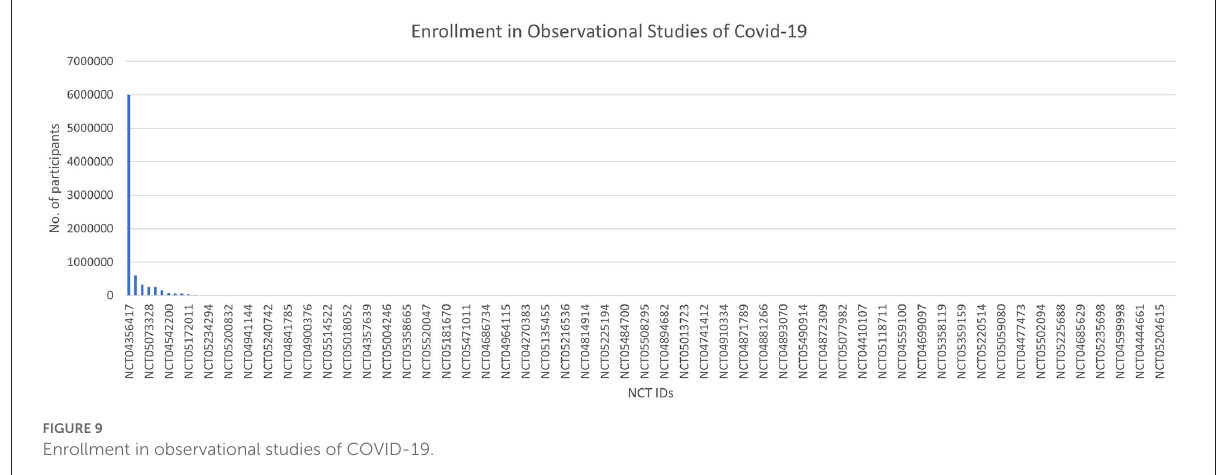
FIGURE9 Enrollment in observational studies of COVID-19.